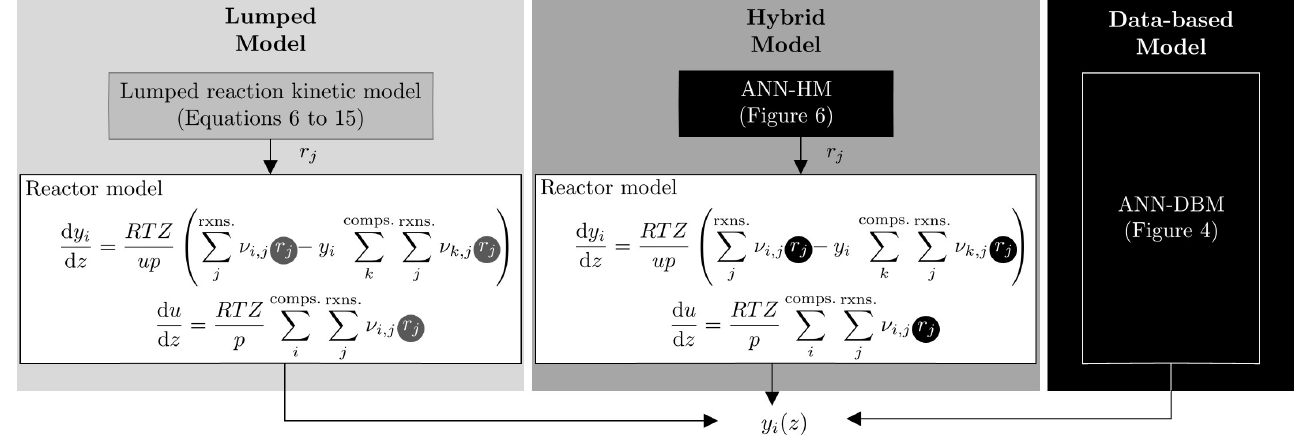
Figure 2. Schematic representation of the lumped, hybrid and data-based models relevant for this